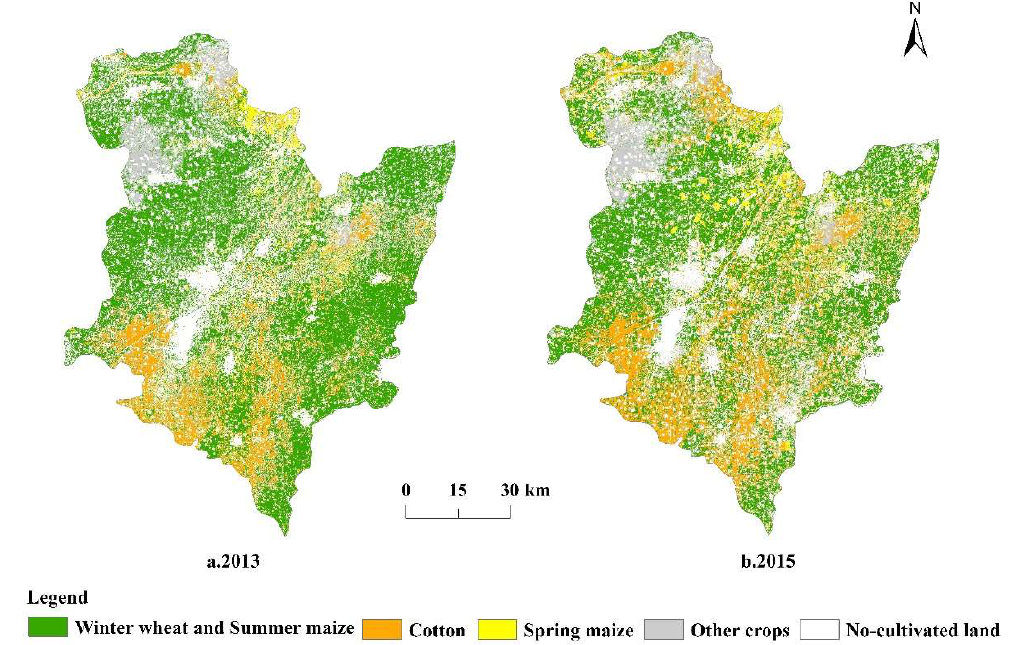
Figure 2. Land-cover in 2013 ( a ) and land cover in 2015 ( b ). Table 3. The area and percentage of each land cover in 2013 and 2015.